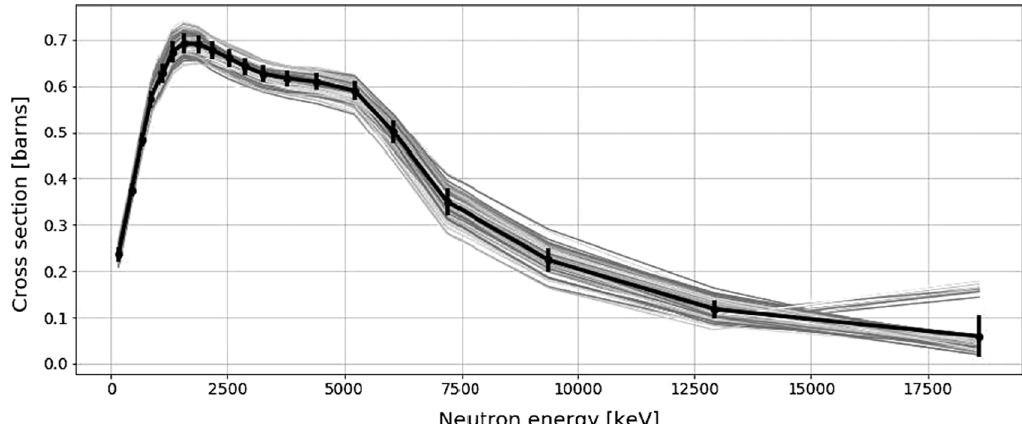
Fig. 4. (n,xn g ) cross sections of the 111 keV g -transition in 184 W obtained with the Monte Carlo procedure. The thick black line is the fi nal cross section associated with its standard